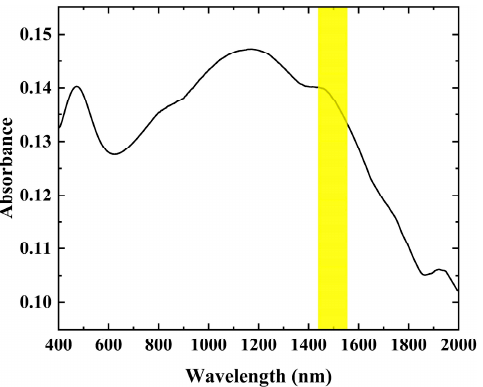
Figure 2. Absorption spectrum of SNPT-PVA composite. The yellow band indicates the typical working wavelength for an EDFL. working wavelength for an